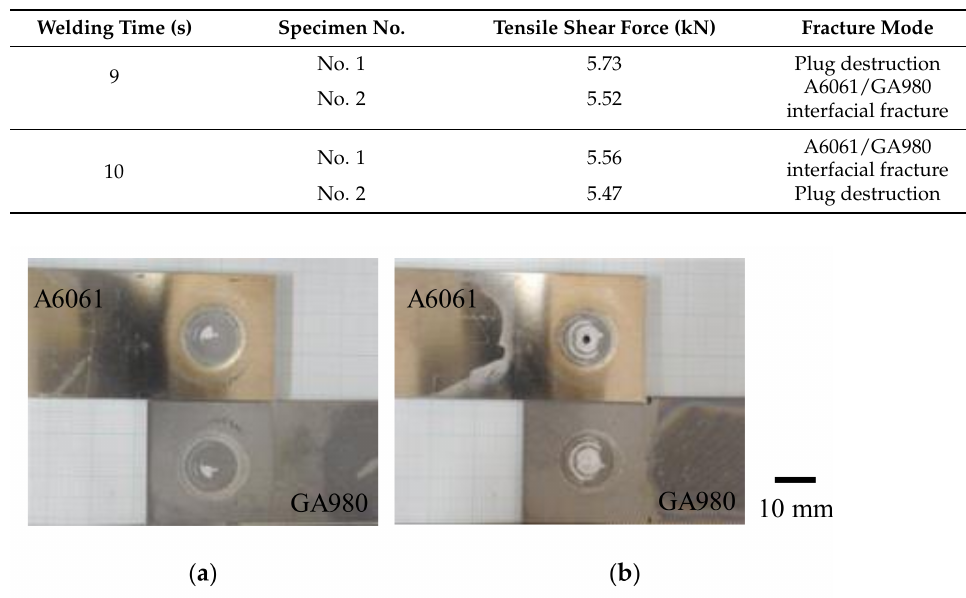
Figure 10. Examples of typical fracture surfaces by tensile shear test. ( a ) A6061/GA980 interfacial fracture (welding time: 9 s, specimen No.: No. 2) and ( b ) plug destruction (welding time: 10 s, specimen No.: No.